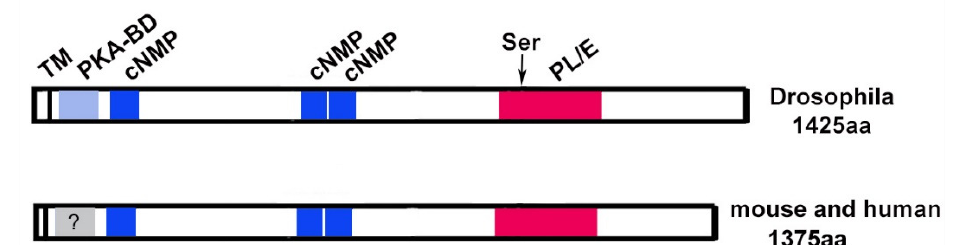
Figure 2. Schematic of PNPLA6/NTE and SWS. The catalytic domain, including the active site serine (arrowhead), is shown in red, the regions showing homology to PKA in blue. The transmembrane domain (TM) is indicated by a vertical line. PKA-BD=domain binding to the catalytic subunit (not confirmed in mammals), cNMP = cyclic nucleotide binding sites, PL/E = phospholipase/esterase domain.